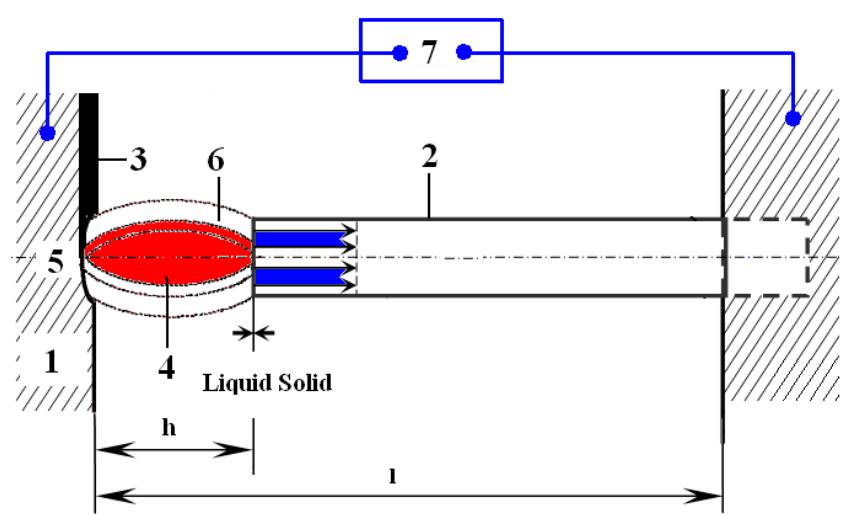
Figure 1. Scheme the electrical discharge alloying coating deposition: 1—substrate (cathode), 2—erode as coating material (anode), 3—coating, 4—plasma, 5—diffusion/reaction zone, 6—protective gas, 7—power generator, h—height plasma and l—length erode.